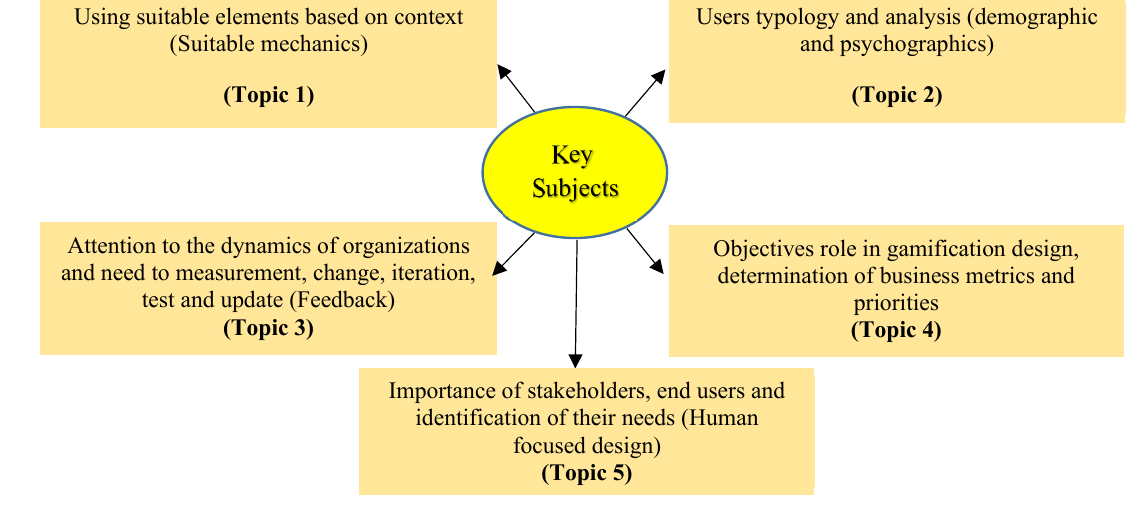
Fig. 3. Key subjects for the enterprise gamification design